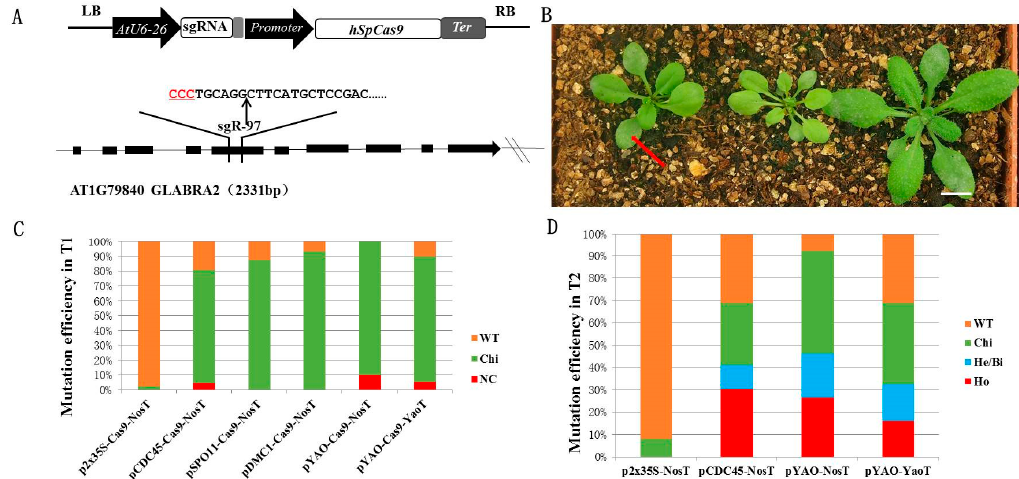
Figure 1. Gene mutagenesis efficiency of cell division specific CRISPR/Cas9 systems in transgenic T1 and T2 generations of Arabidopsis . ( A ) Structure of the CRISPR/Cas9 binary vectors and sequence of the target site in GLABRA2. The hSpCas9 gene is driven by the cell division specific promoters CDC45 , DMC1 , SOP11 , and YAO as well as the constitutive 2x35S CaMV promoter, while the AtU6-26 promoter controls transcription of the sgRNA. The sequence of GL2-sgR97 is shown. hSpCas9 , human codon-optimized SpCas9 ; Ter, Nos or YaoT terminator. The PAM sequence is underlined in red. ( B ) Phenotypes of T1 generation plants transformed with the pCDC45-Cas9 construct. A chimera showing an incomplete glabrous phenotype, a plant showing a uniform glabrous phenotype and a wild type phenotype are shown from left to right. T1 seedlings were transplanted to soil and grown under long-days (16 h light/8 h dark) for two weeks before photographing. Red arrow shows a leaf with a chimeric phenotype. Bar: 1 cm. ( C ) Mutation efficiency in transgenic T1 lines. Approximately 40 individual T1 plants were tested for each construct. NC: non-chimeric mutants (homozygous, bi-allelic, heterozygous); Chi: chimera; WT: wild type. ( D ) Mutation efficiency in transgenic T2 generation. Ho: homozygous; He/Bi: heterozygous/bi-allelic; Chi: chimera; WT: wild type.